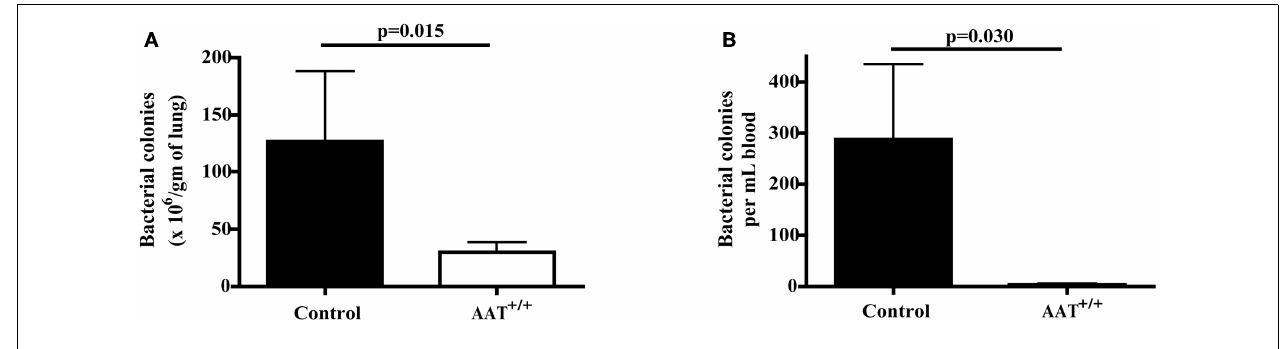
tissues and blood samples collected and processed as described in Section “Materials and Methods.” Bacterial concentrations were quantified in lungs (A) and in blood (B) . Graphs depict means + SEM and p -values are indicated in the